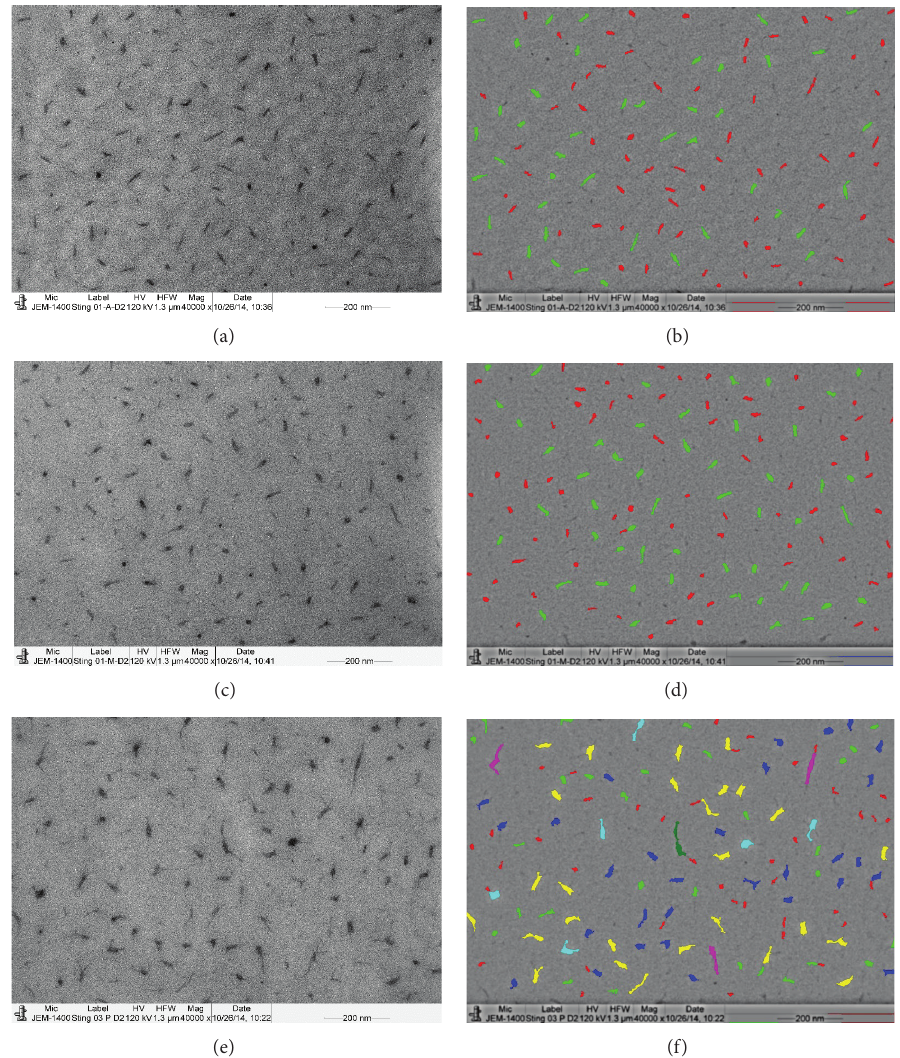
Figure 6: Electron micrograph and colour coded digital images of the PGs of stingray. The electron micrograph was taken from section of corneal stroma that was not stained with uranyl acetate and lead citrate; (a) electron micrograph of PGs of the anterior stroma; (b) colour coded digital image of (a); (c) electron micrograph of PGs of the middle stroma; (d) colour coded digital image of (c); (e) electron micrograph of PGs of the posterior stroma. Please note that PGs are star shaped; (f) colour coded digital image of (e). Red: 50–257, green: 257–464,